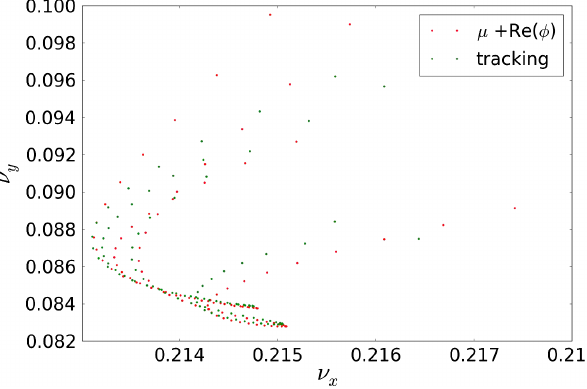
FIG. 10. Tune footprint from tracking (green) and theory (red).